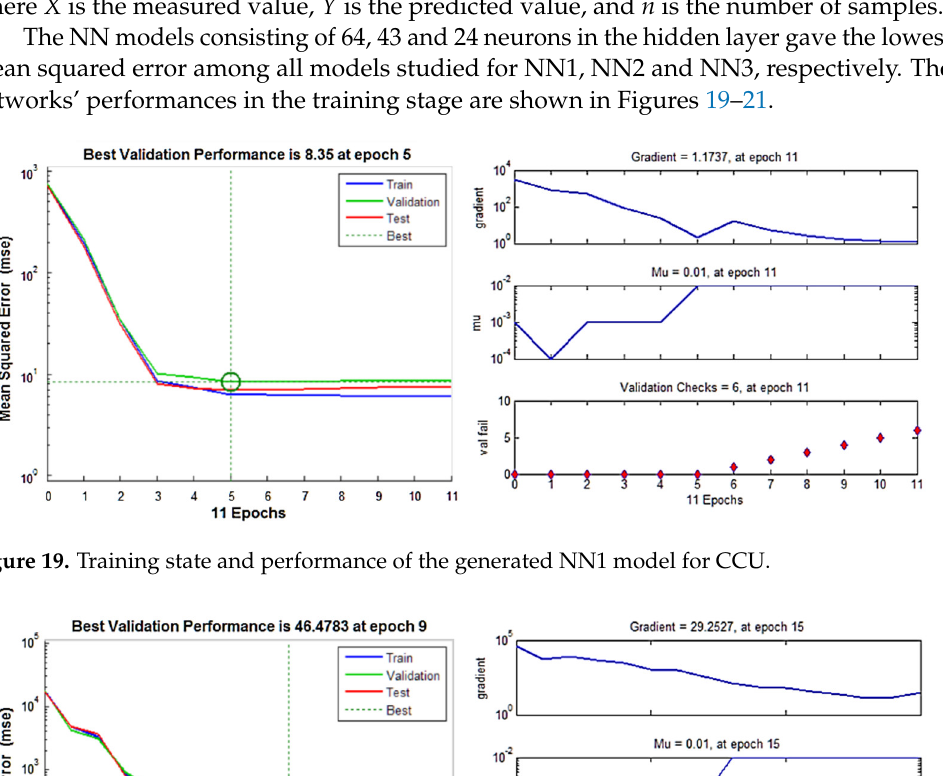
Figure 21. Training state and performance of the generated NN3 model for TCU.